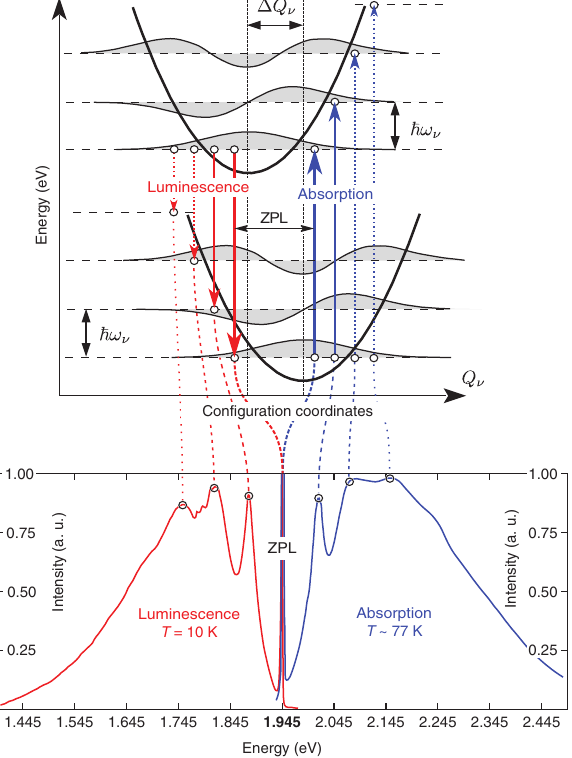
Figure 8: (Top) Total energy against configuration coordinate sketches the APES. The configuration coordinate is related to the position of ions. ħ ω is the energy quantum of the (effective) ν ν phonon mode in quasiharmonic approximation, i.e. parabolic APES. In the Huang-Rhys approximation, the APES of excited state (top parabola) and that of the ground state (bottom parabola) are the same but the minima shifted by Δ Q . The wave functions of the ν phonons are shown, and the overlap of the phonon wave functions of the two APES will appear as phonon sideband in the optical spectra. (Bottom) Absorption and emission spectra of NV center in diamond at low temperatures. The phonon modes coupled strongly to the optical transition can be identified as bumps in the phonon sideband of the corresponding spectrum. ZPL is the ZPL optical transition. Note that the two spectra are not identical in the phonon sideband as features at about −0.15 eV from ZPL are visible in the luminescence spectrum that are missing at + 0.15 eV from ZPL in the absorption spectrum. These features are explained by the vibronic nature of the 3 E state (see Refs. [105,